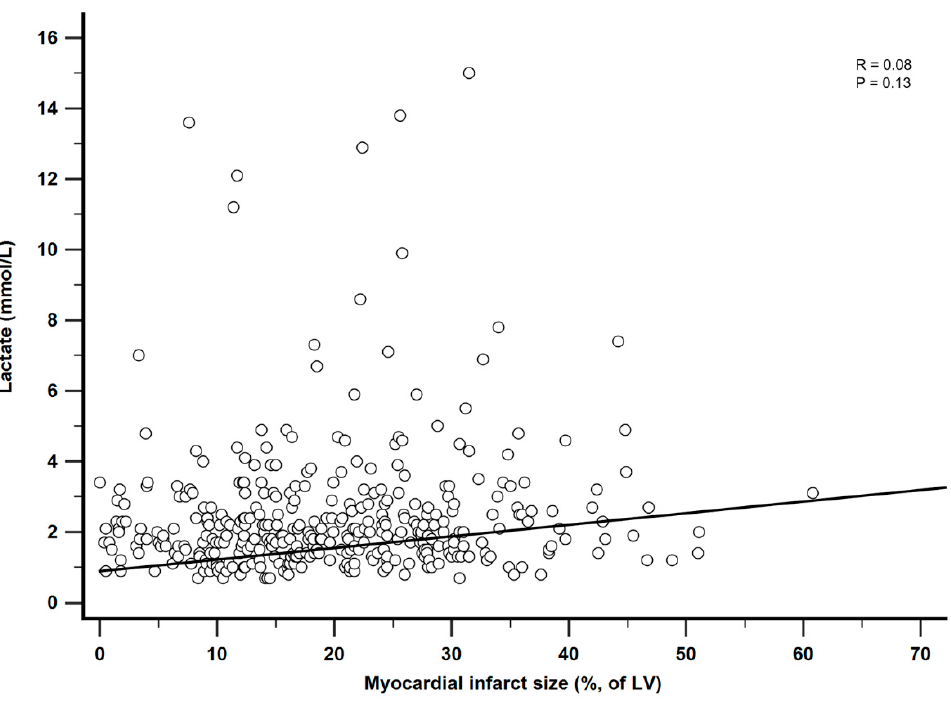
Figure A1. Relation between serum lactate levels and myocardial infarct size. Scatter plot is presented to show the linear relation calculated from linear regression analysis between baseline serum lactate levels and myocardial infarct size. LV = left ventricle.